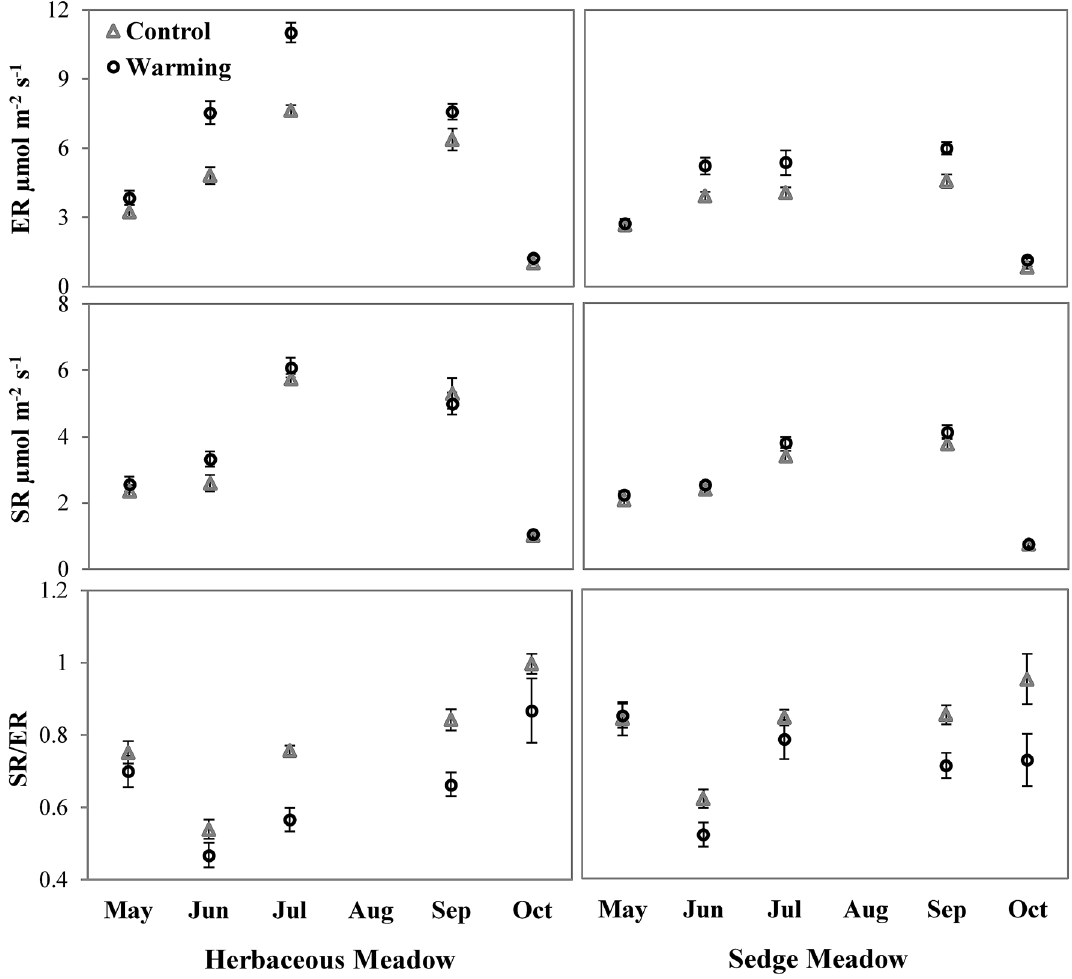
Figure 2. Warming effects on ecosystem respiration (ER) , soil respiration (SR) and SR/ER ratio at Herbaceous and Sedge Meadows. Data show mean ±